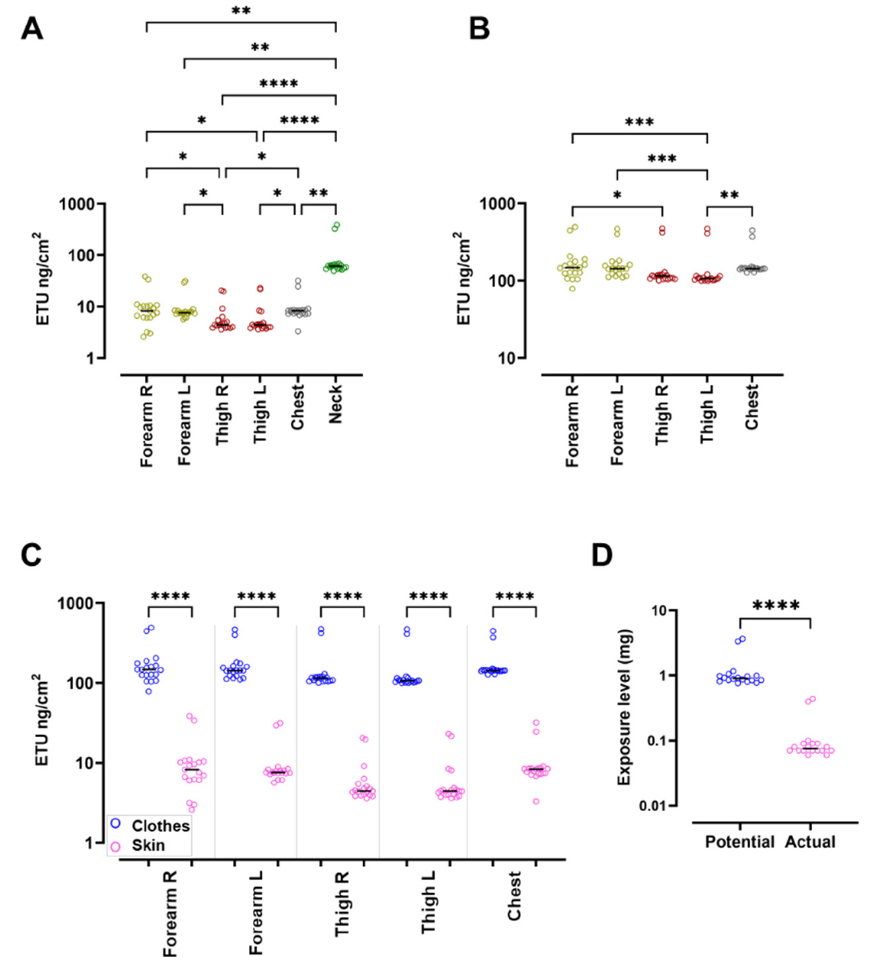
Figure 3. Levels of ETU measured in the pads located on the skin and on the clothes. ( A ) Levels of ETU expressed in ng/cm 2 detected in skin pads. ( B ) Levels of ETU expressed in ng/cm 2 detected in clothes pads. ( C ) Levels of ETU expressed in ng/cm 2 detected in pads of same body location of both skin and clothes. ( D ) Box plot showing the potential and actual exposure values (expressed in mg) considering all the enrolled subjects. ( A , B ) Yellow circles, forearm; red circles, thigh; grey circles, chest; green circles, neck. ( C , D ) Blue circles, pads applied on clothes; pink circles, pads applied on skin. ( A – C ) Friedman test multiple comparisons with Dunn’s post-test. ( D ) Wilcoxon test matched pairs. Data are reported as dot plots with median values. * p < 0.05; ** p < 0.01; *** p < 0.001; **** p < 0.0001. Where no asterisk is reported, the comparison between groups is not significant. Levels of ETU detected in skin pads were significantly higher in the neck pad,